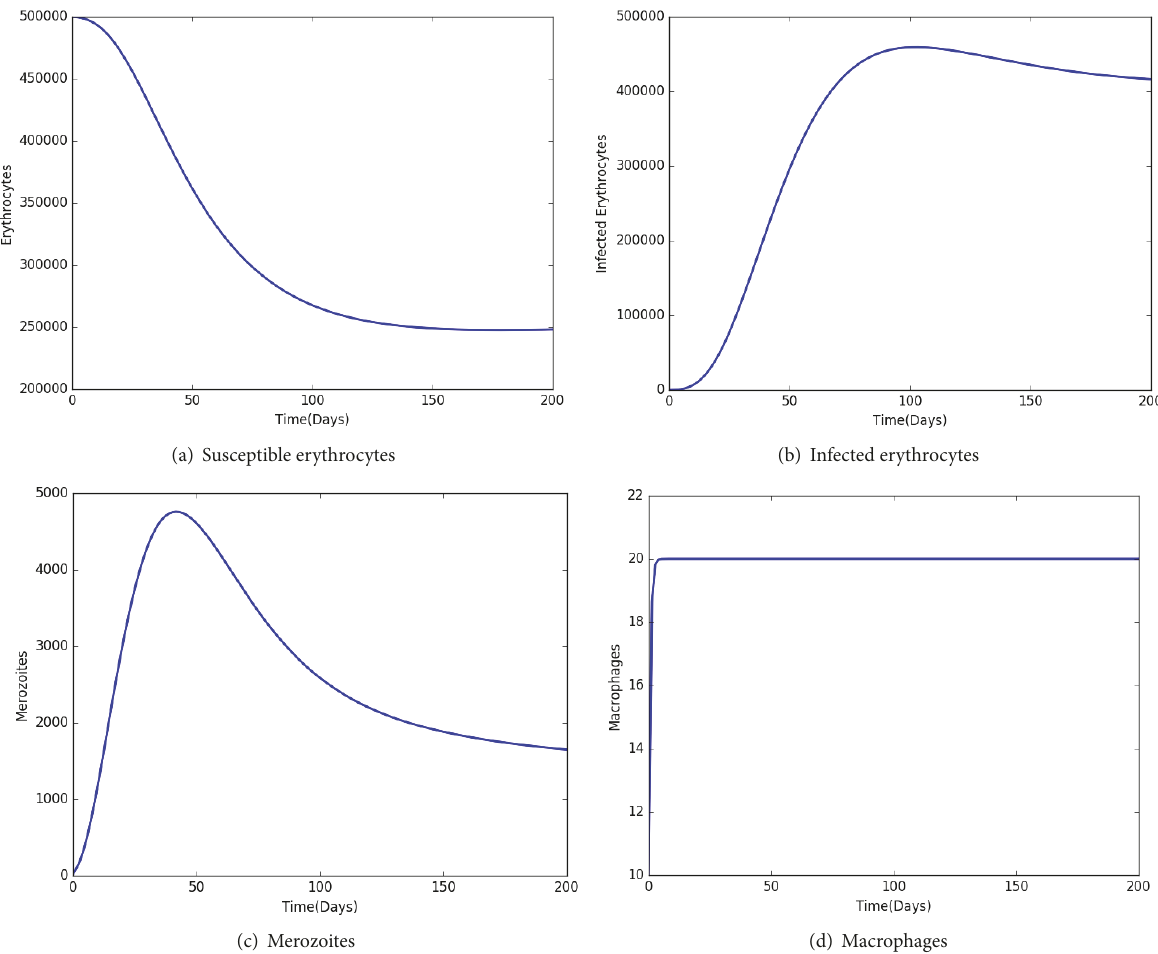
Figure 5: Graphs showing population dynamics of red blood cells, macrophages, and malaria merozoites when 𝑅 0 = 1.58690 > 1 . Simulation parameter values are available in Table